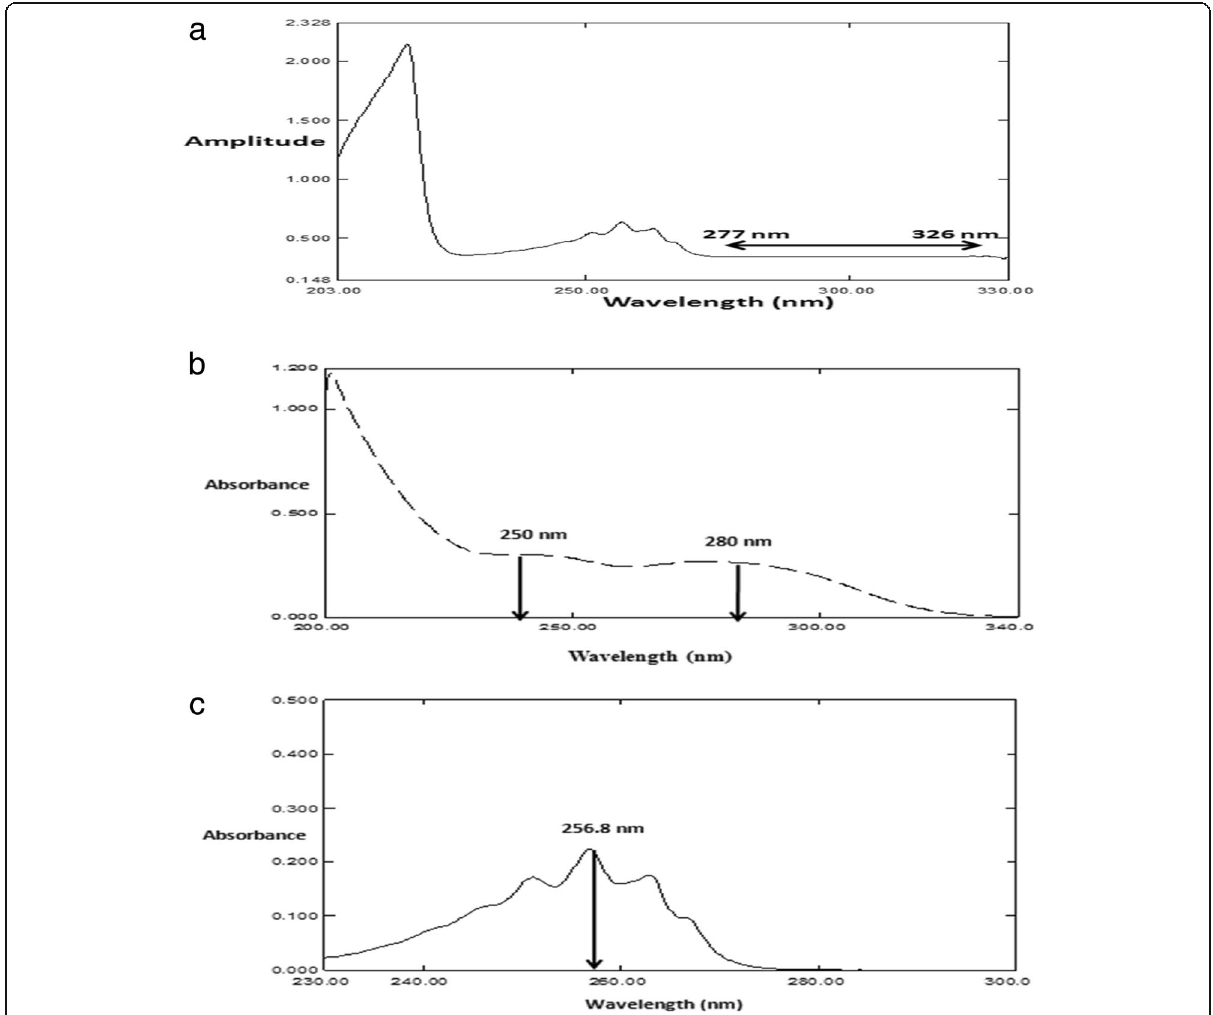
Fig. 5 a Ratio spectrum of binary mixture using LOR (30.0 μ g/mL) as a divisor and measure the constant at 277 – 326 nm. b The obtained zero- order spectrum of LOR after multiplication by LOR (30.0 μ g/mL). c The obtained zero-order spectrum of PSE after spectrum subtraction